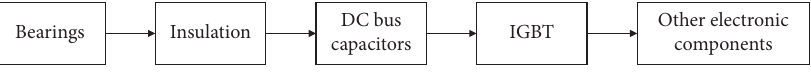
Figure 4: Series model of the motor system.